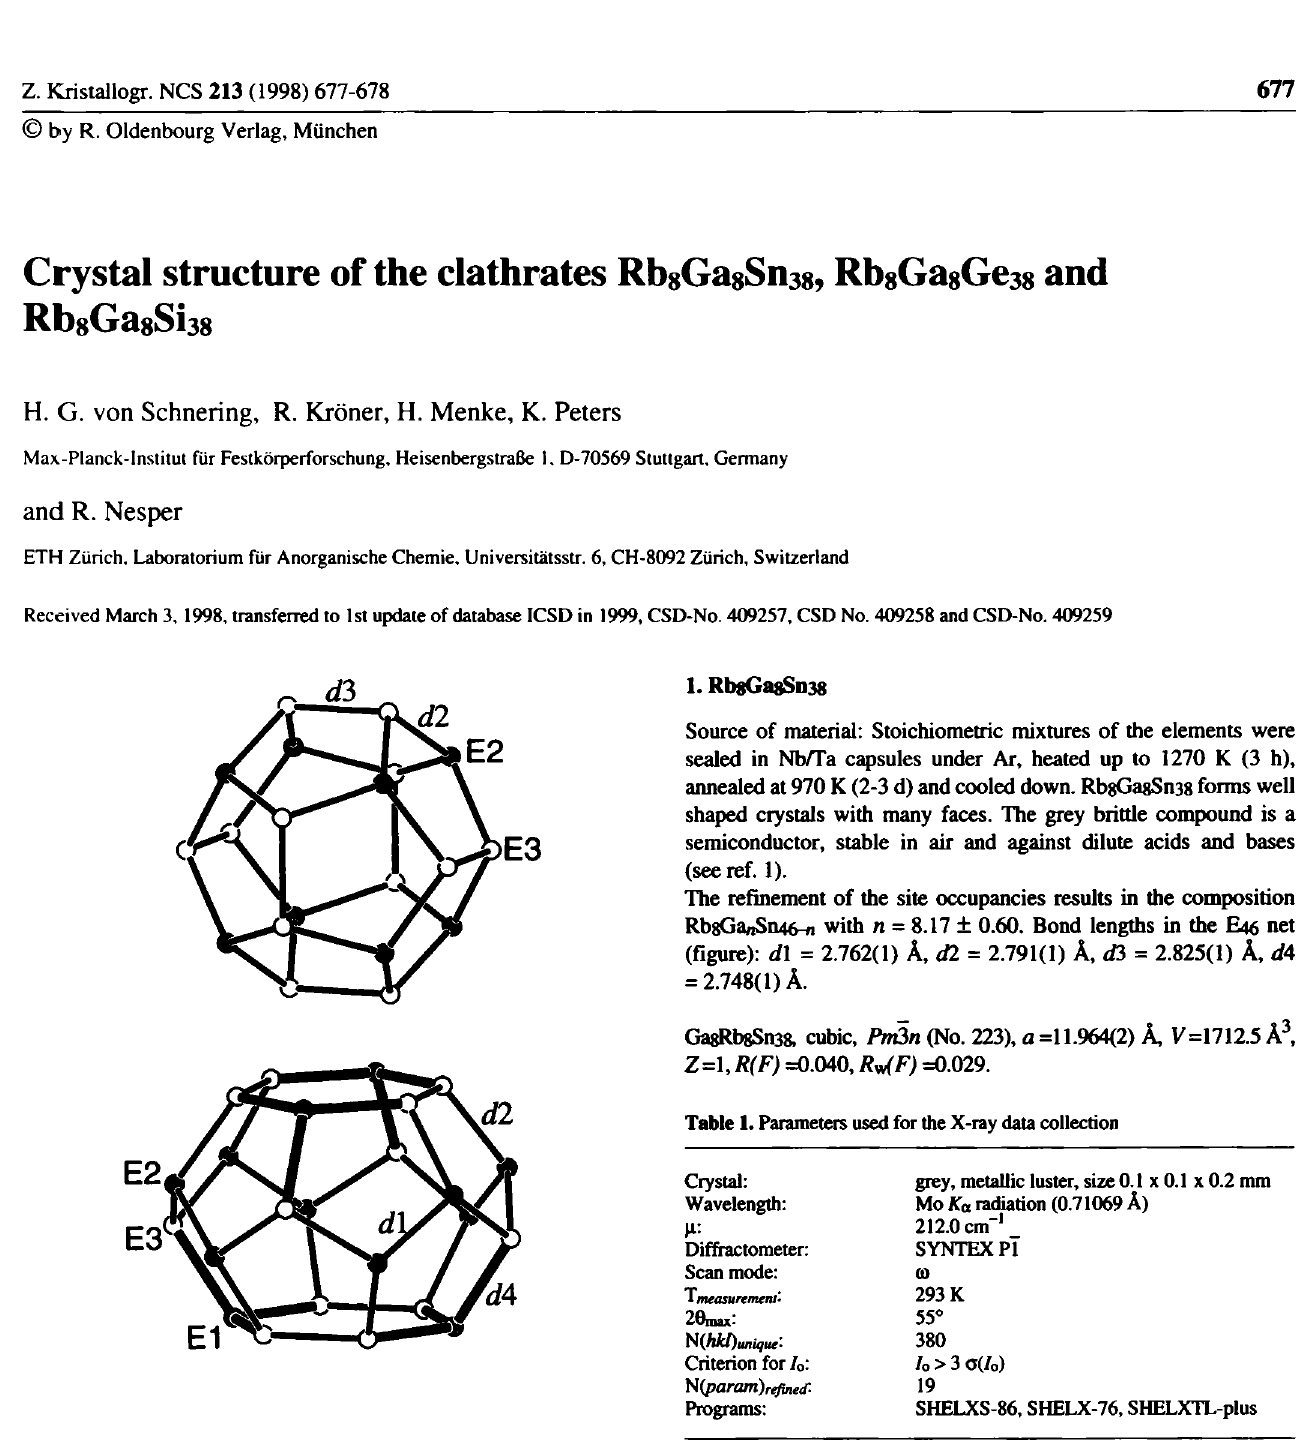
Table 2. Final atomic coordinates and displacement parameters (in Â^) Atom Site